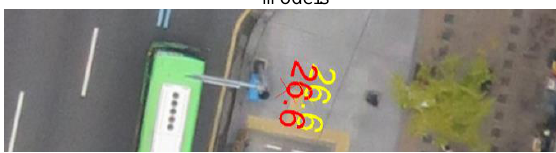
Figure 10. Horizontal position comparison between adjacent